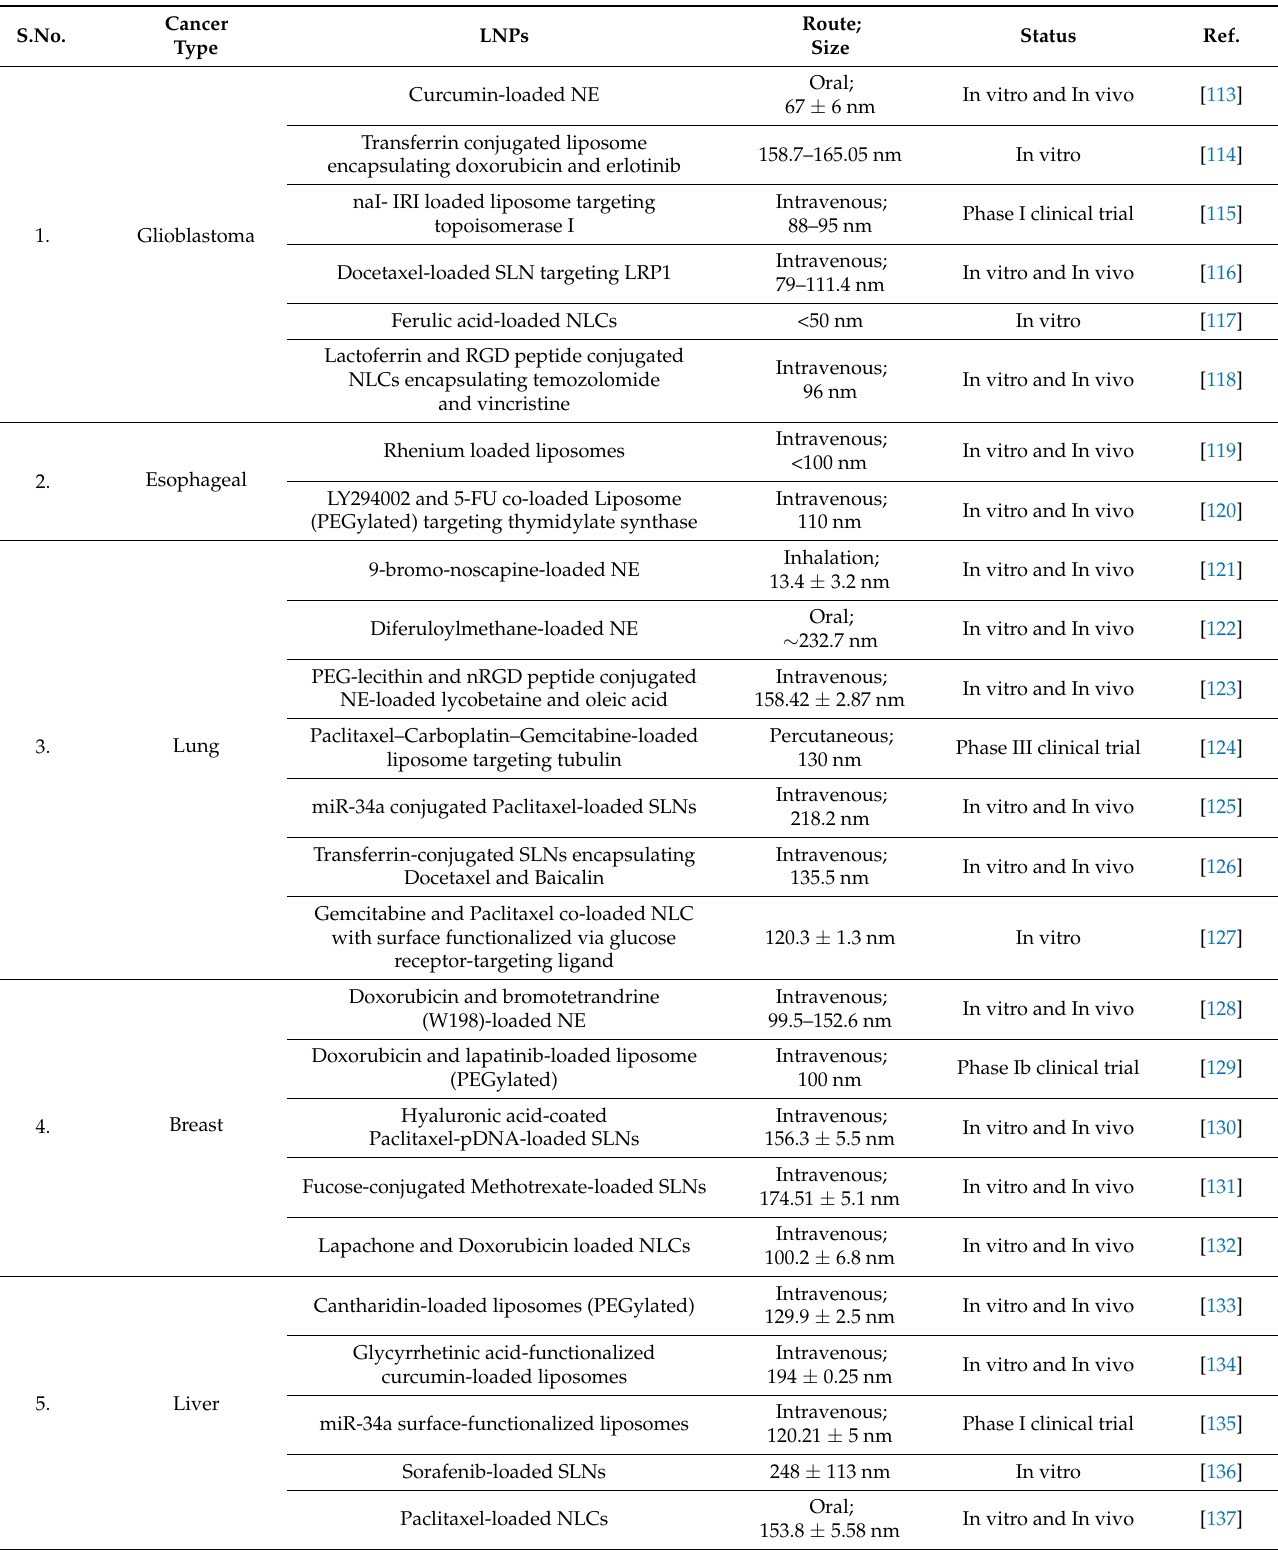
Table 5. List of LNPs subjected to pre-clinical trials and clinical